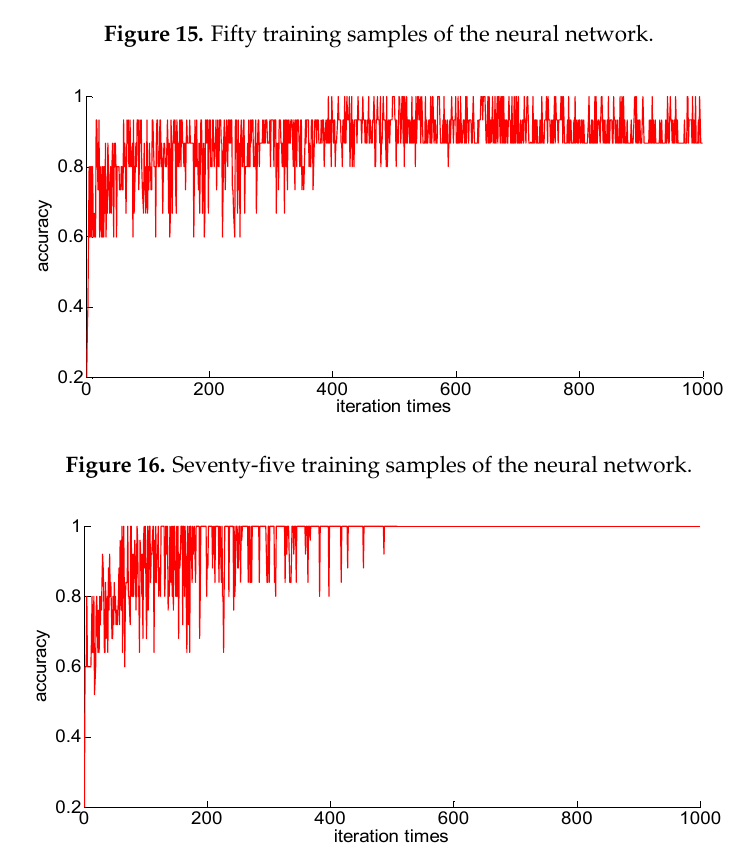
Figure 17. One hundred training samples of the neural network.